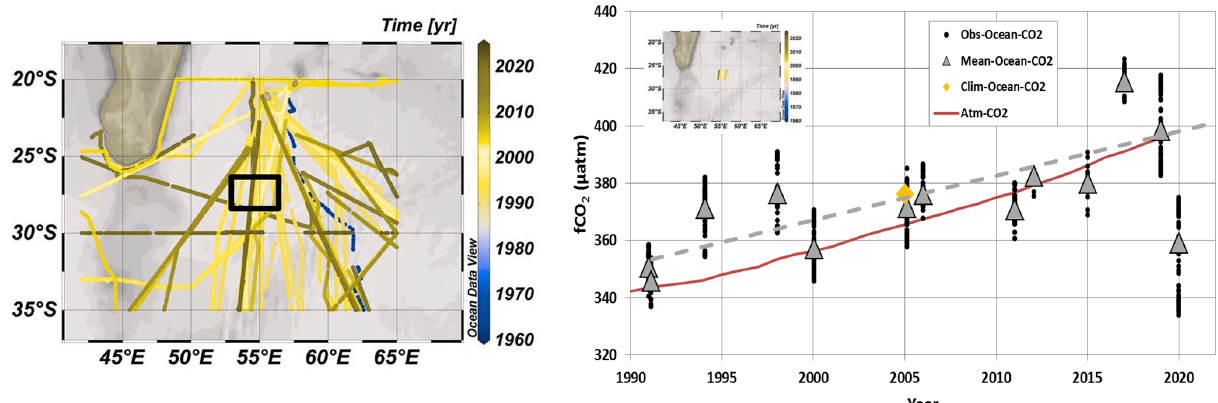
Figure 2. On the left are shown tracks of cruises with sea surface f CO 2 data available in the south-western Indian Ocean in the SOCAT data product (Surface Ocean CO 2 Atlas; SOCAT v2021, Bakker et al., 2016, 2021). On the right is shown a time series of f CO 2 data (black dots) and mean f CO 2 for each period (grey triangles) at 27–28 ◦ S, 55 ◦ E (black square in the map and insert on the right) for the months of January and February (data available from 1991 to 2020 for austral summer). The red curve is the atmospheric f CO 2 . Although over 1991–2019 the ocean f CO 2 increased by + 1.55 ( ± 0 . 40)µatmyr − 1 (dashed grey line) due to anthropogenic CO 2 uptake, the f CO 2 recorded in January 2020 in the bloom were low compared to previous years with some values below 340µatm, i.e. lower than in 1991. The January–February- averaged f CO 2 in the same region derived from the 2005 climatology of Takahashi et al. (2014) is also plotted (orange diamond). Map on the left produced with ODV (Schlitzer,